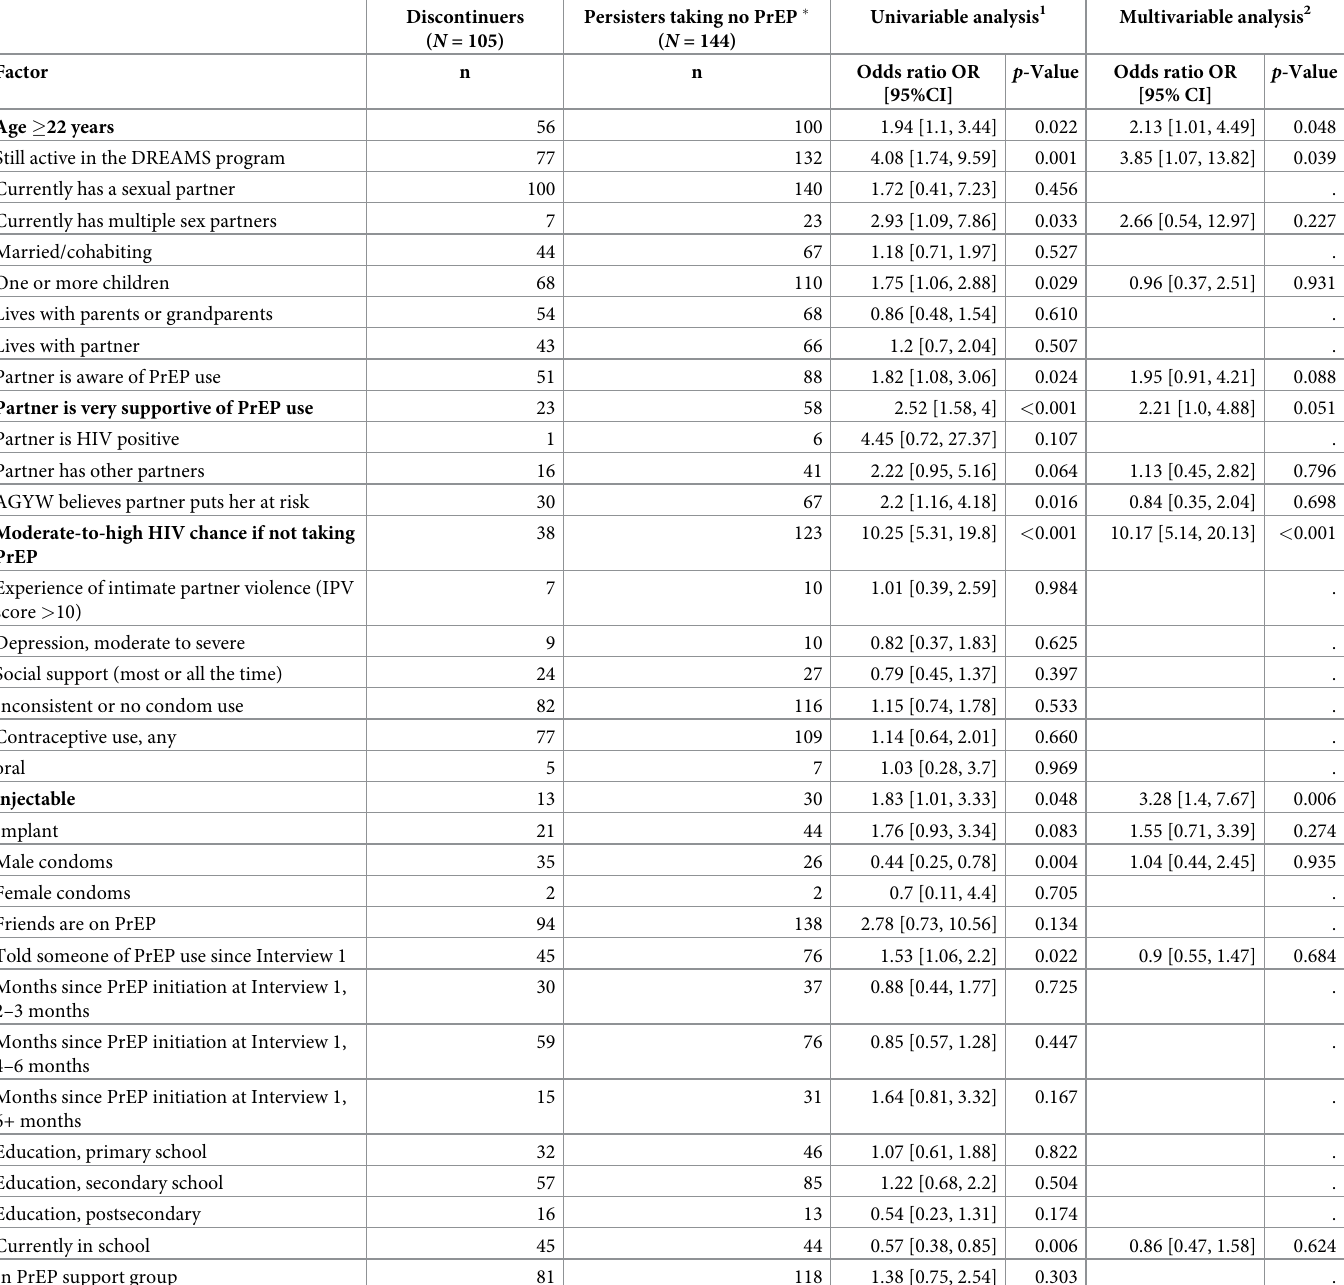
Table 2. Factors associated with Persistence despite poor adherence (Discontinuers vs. Persisters who did not take